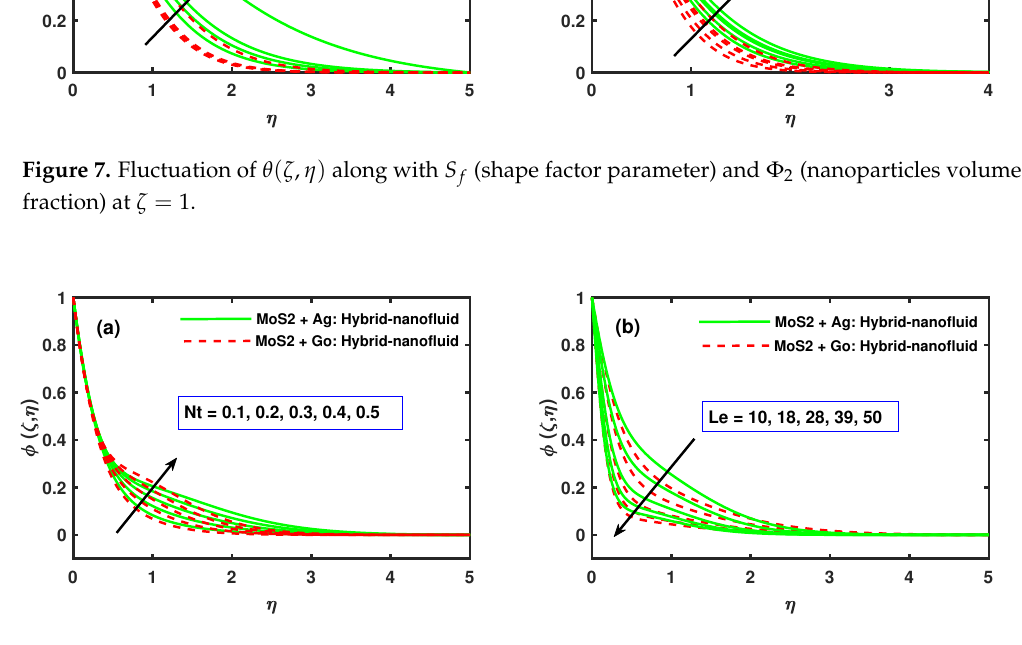
Figure 8. Fluctuation of φ ( ζ , η ) along with Nt (thermophoresis) and Le (Lewis number) at ζ = 1.